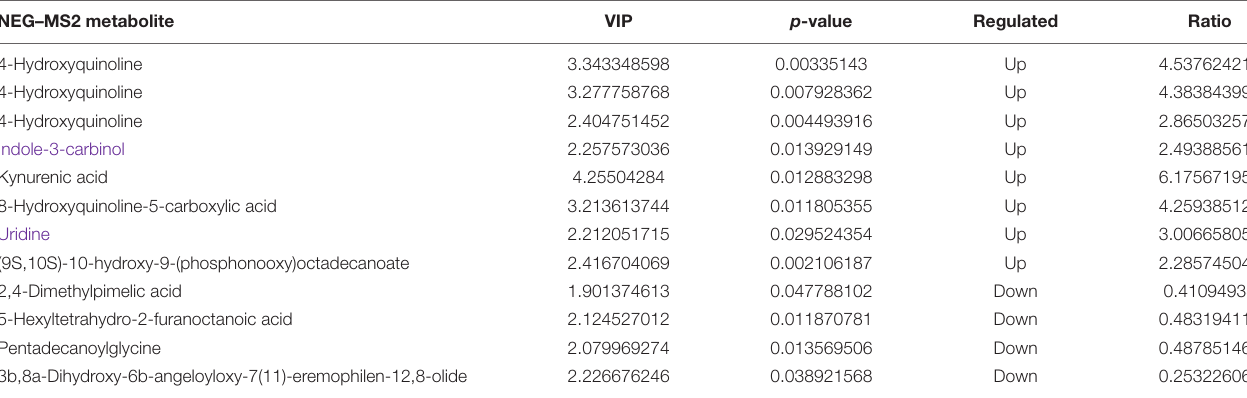
TABLE 3 | Statistics of identified metabolites: Differences in metabolites in the colon of RES and diquat groups in negative ion model. NEG–MS2